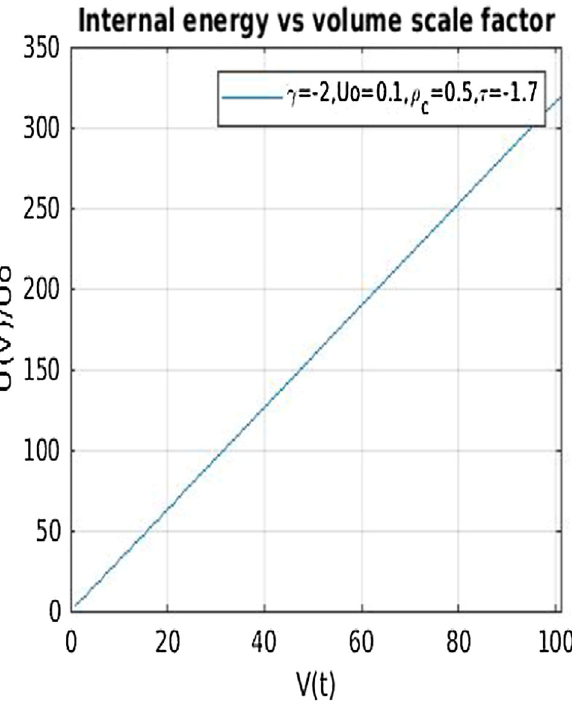
Fig. 5 Graph for internal energy; γ = − 2 ; U 0 = 0 . 5 ; τ = − 1 . 7